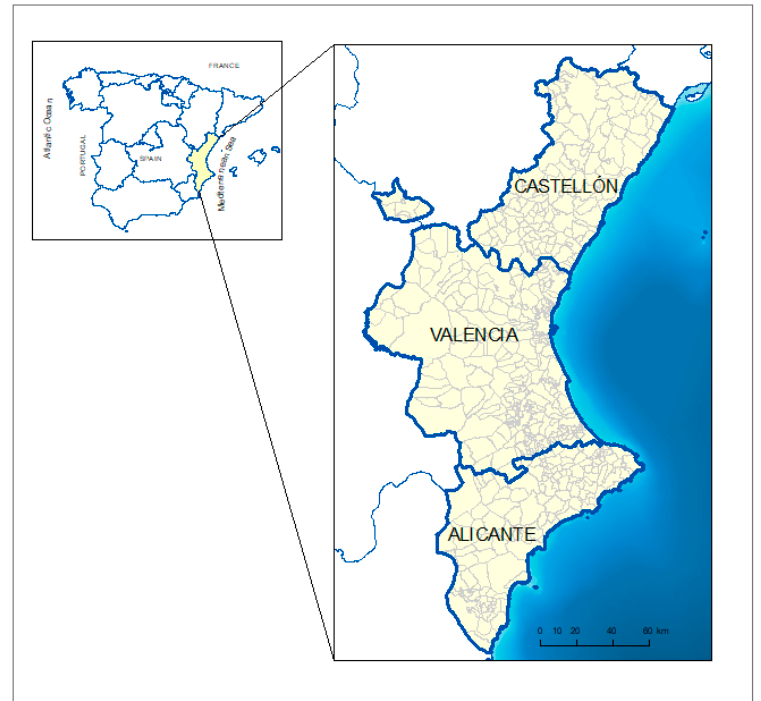
Figure 1. Valencian Community location map.